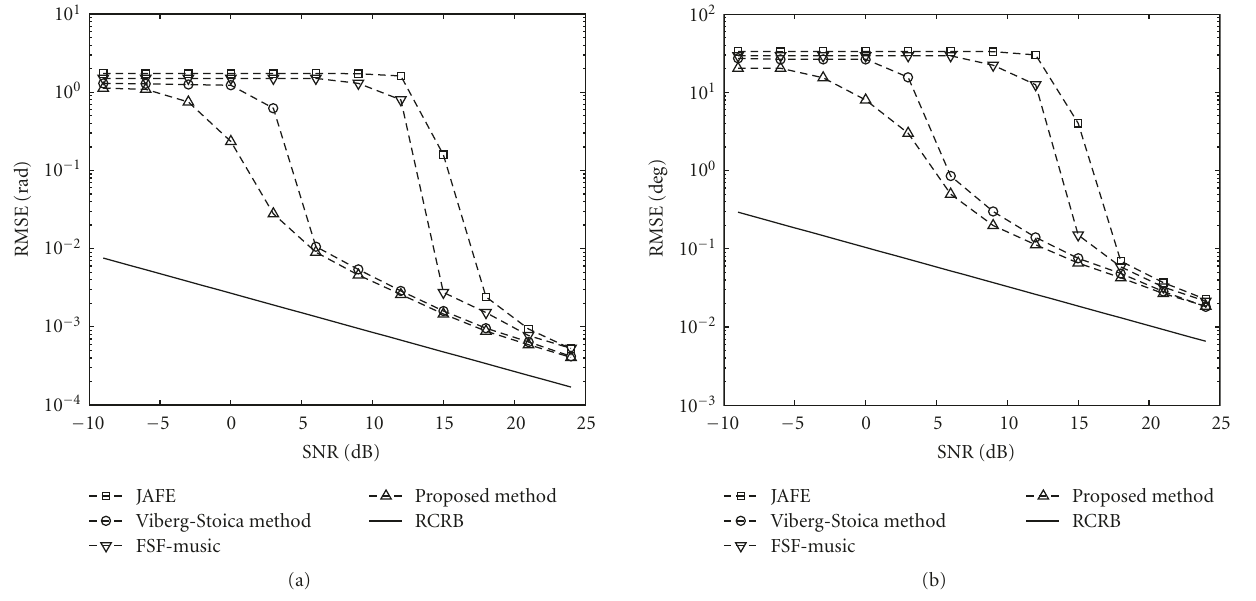
Figure 9: RMSE curves of four methods for frequency and DOA estimation of the first signal versus SNR and the corresponding RCRB in both spatially and temporally colored noise with fixed M = 12, N = 100, and K = 4. (a) Frequency estimation. (b) DOA